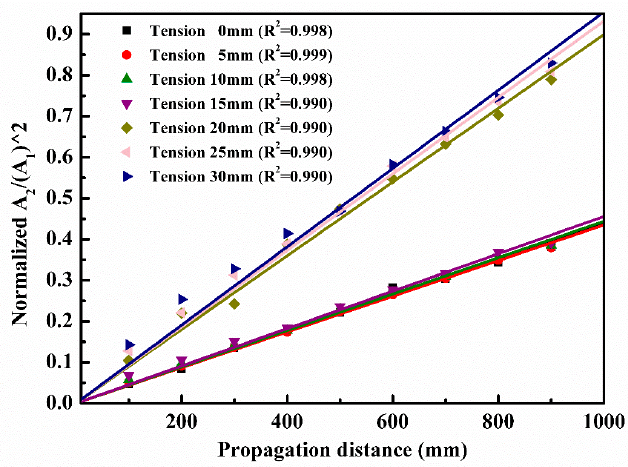
Figure 9. Amplitude ratio A 2 / A 2 , a measure of the nonlinearity parameter β , plotted as a function of propagation distance for the seven models (linearly fitted lines passing through the origin). Materials 2017 , 10 , 827